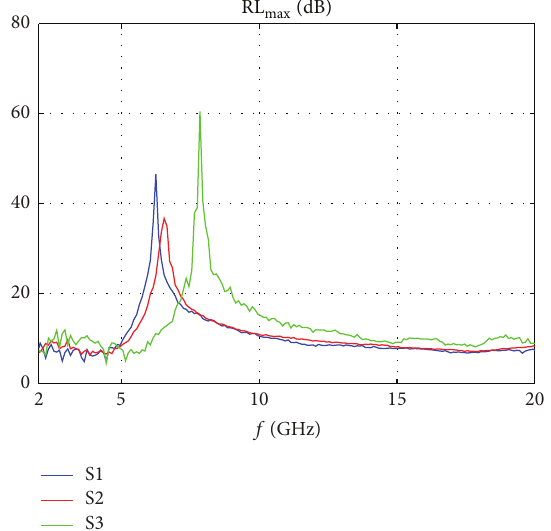
Figure 7: Envelopes of the RL( 𝑓,𝑑 ) curves of the S1, S2, and S3 ferrite. Thickness 𝑑 ranges up to 5